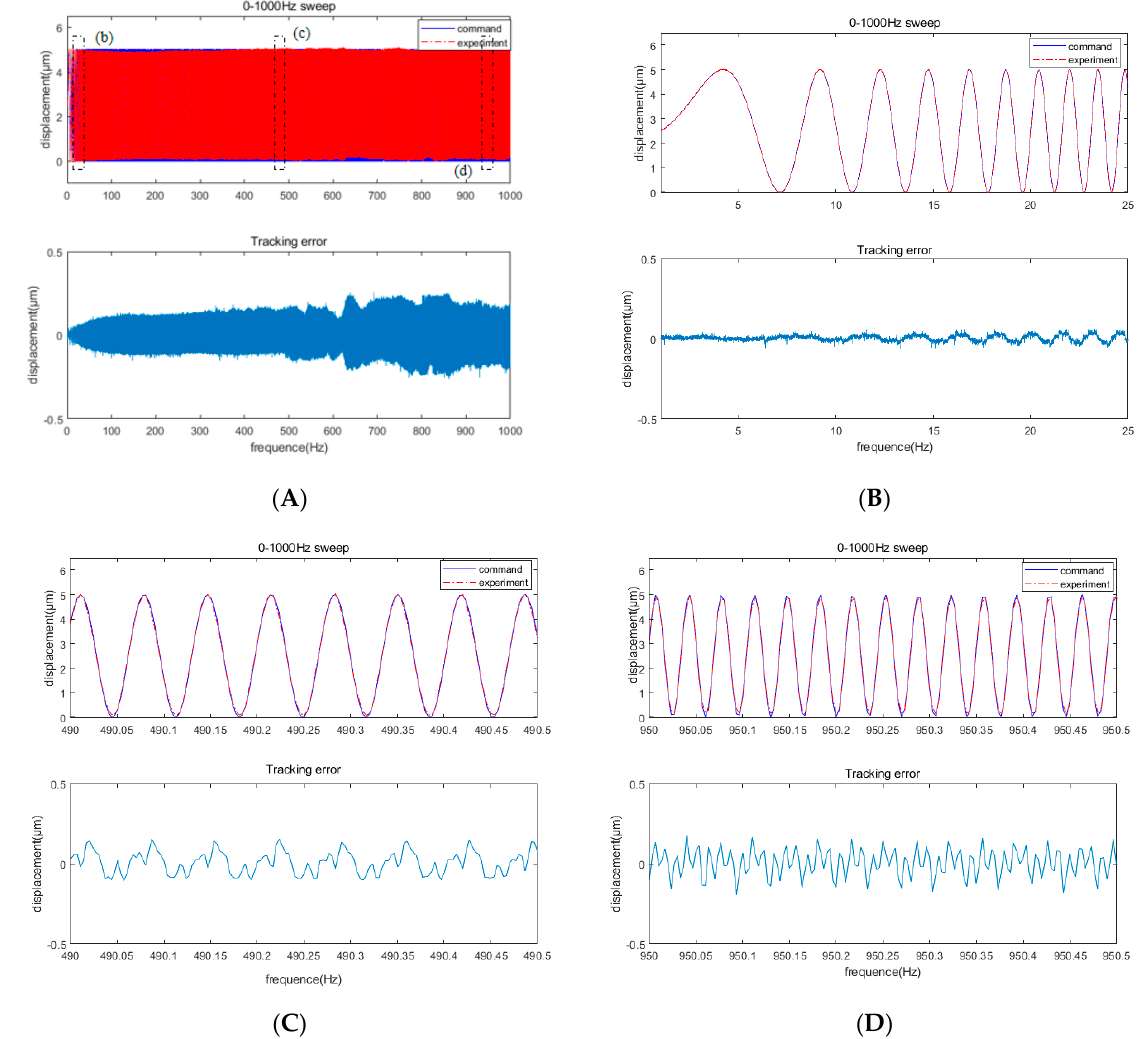
Figure 16. ( A ) Tracking error of the 0–1000 Hz sinusoidal sweep signal; ( B ) local amplification of Region B; ( C ) local amplification of Region C; ( D ) local amplification of Region D.